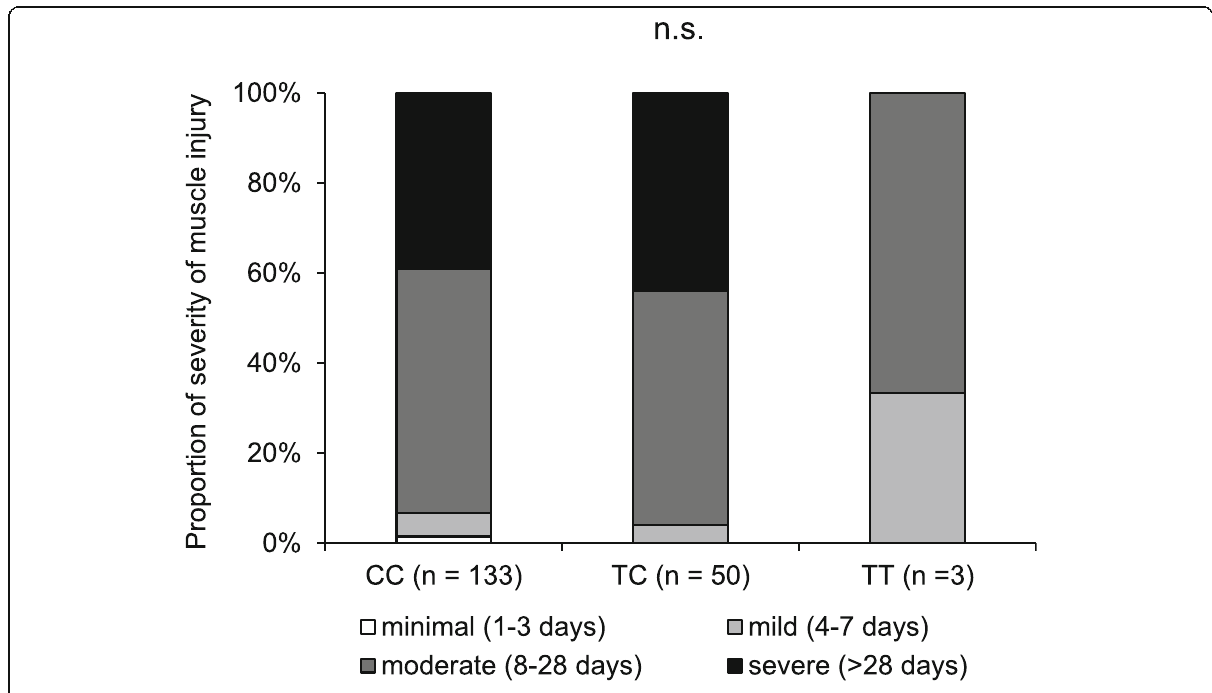
Fig. 2 Proportion of severity of muscle injury by the COL5A1 rs12722